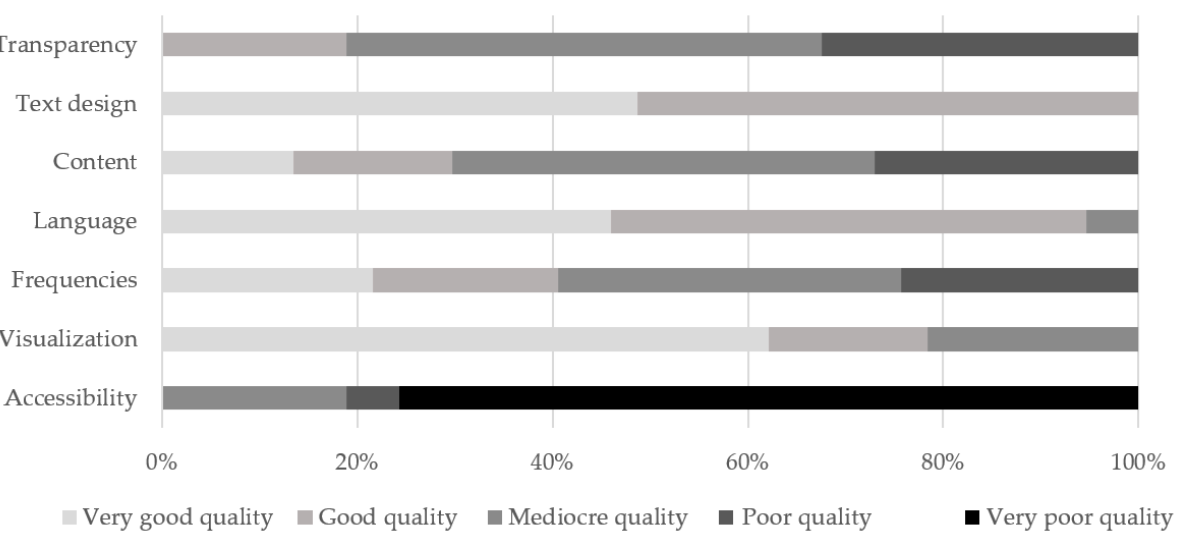
Figure 1. Quality of the evaluated materials (n = 37) on the basis of 7 main categories and 60 subcriteria in percent.